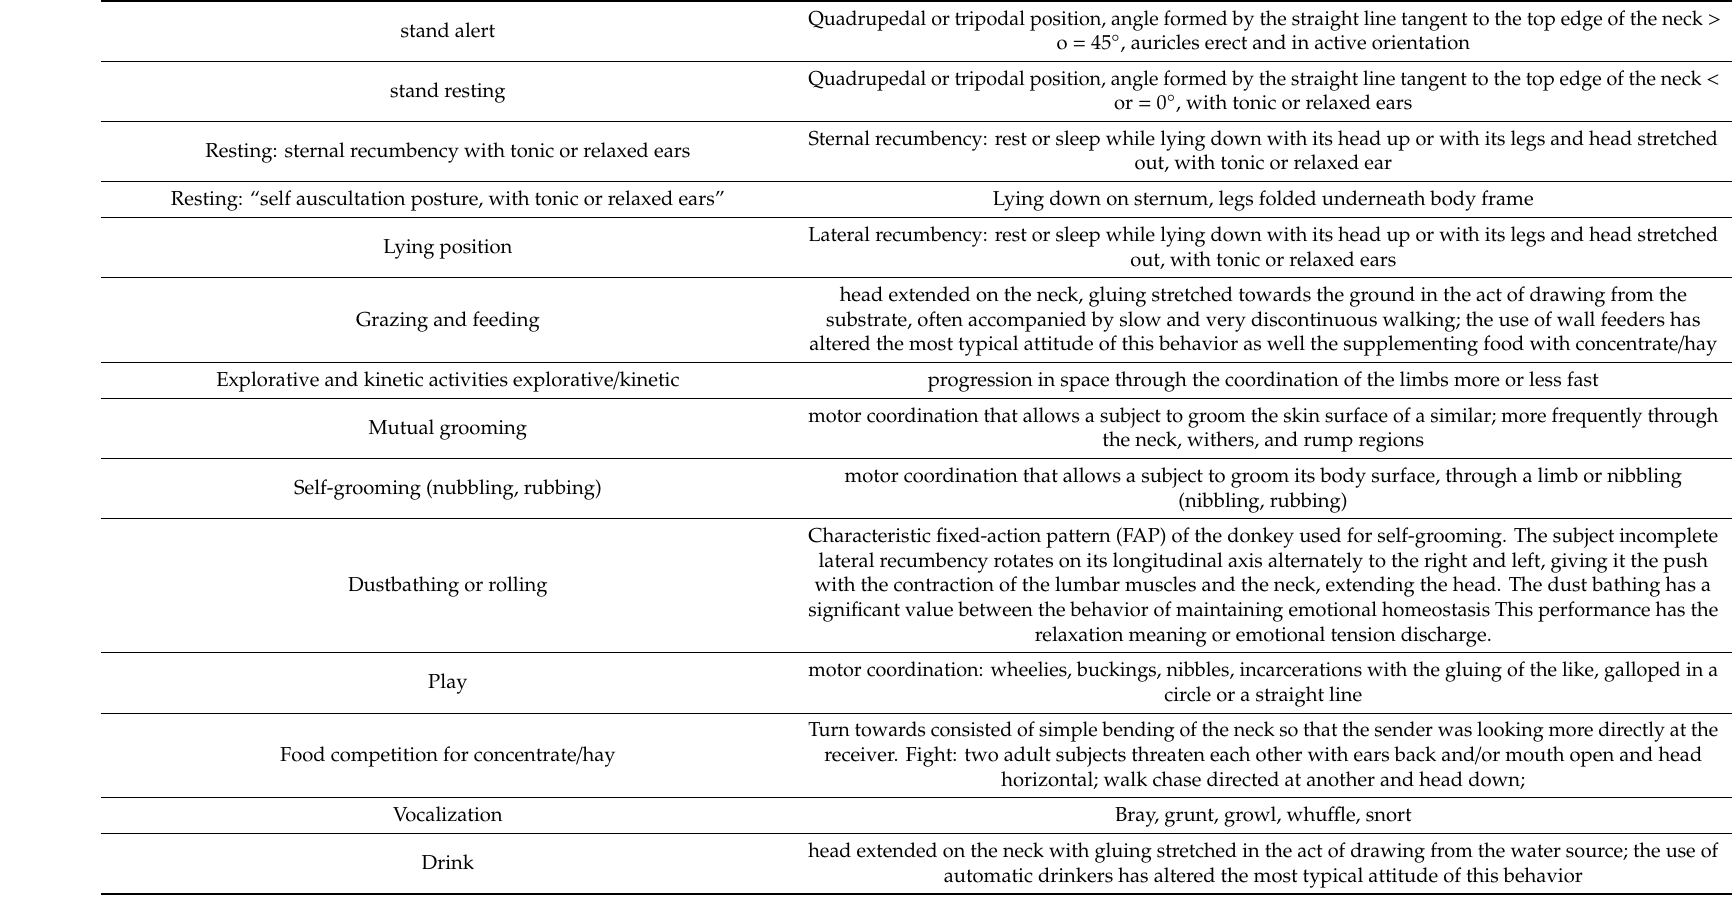
Table 1. Ethogram: description of the selected behavioral states or behavioral events of Equus asinus L. stand